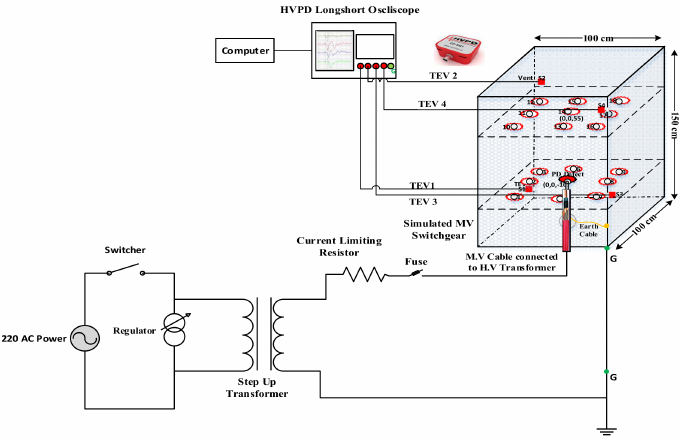
Figure 2. Experimental setup.